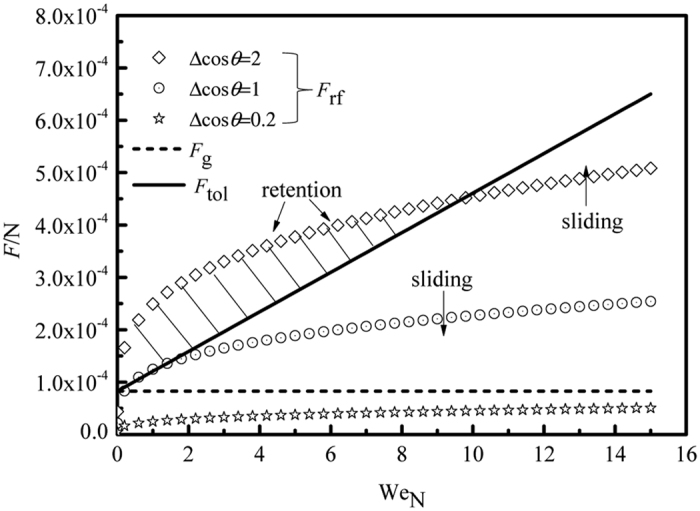
Theoretical values of Frf, Ftol and Fg as a function of WeN.To simplify the problem, three values of (i.e., 2, 1 and 0.2) are considered to calculate Frf.